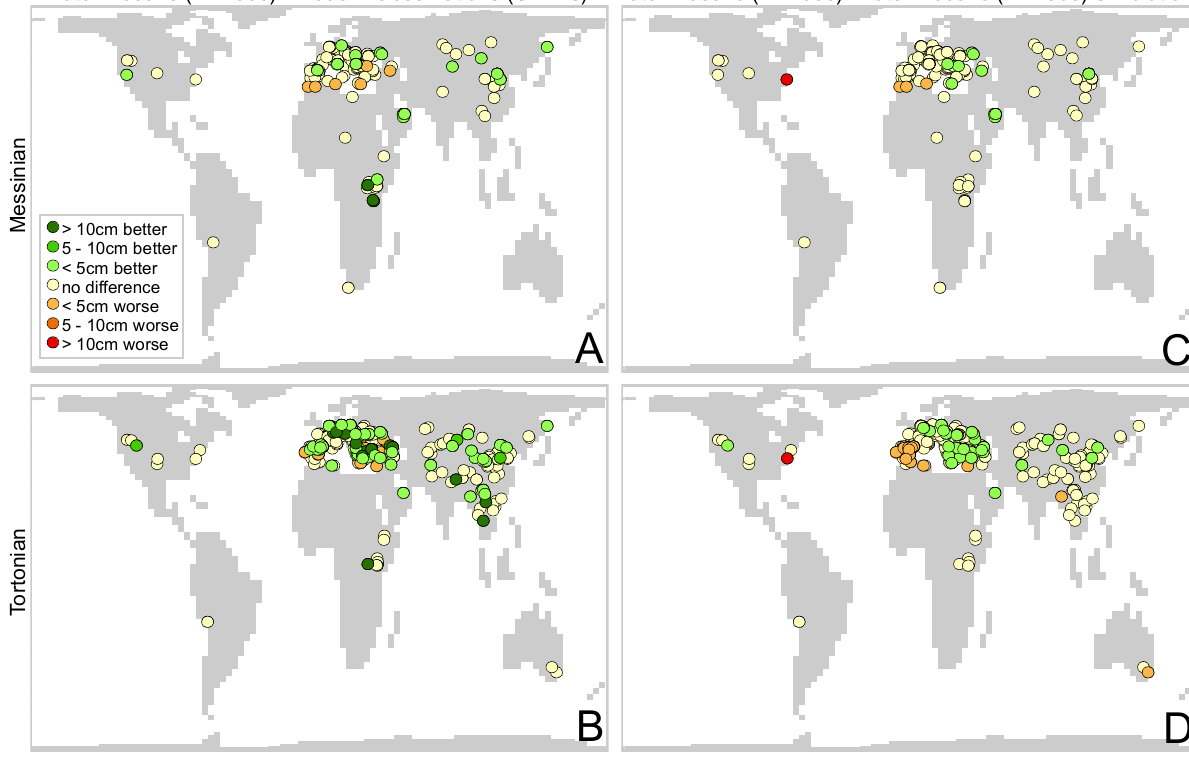
> 10cm better 5 - 10cm better